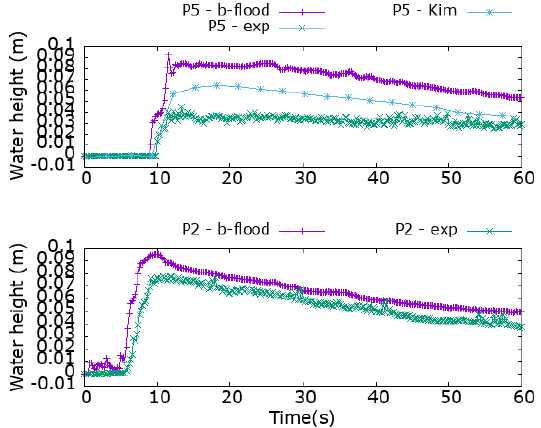
Figure 16. Water depths for the experiment and b-flood for gauge stations P5 and